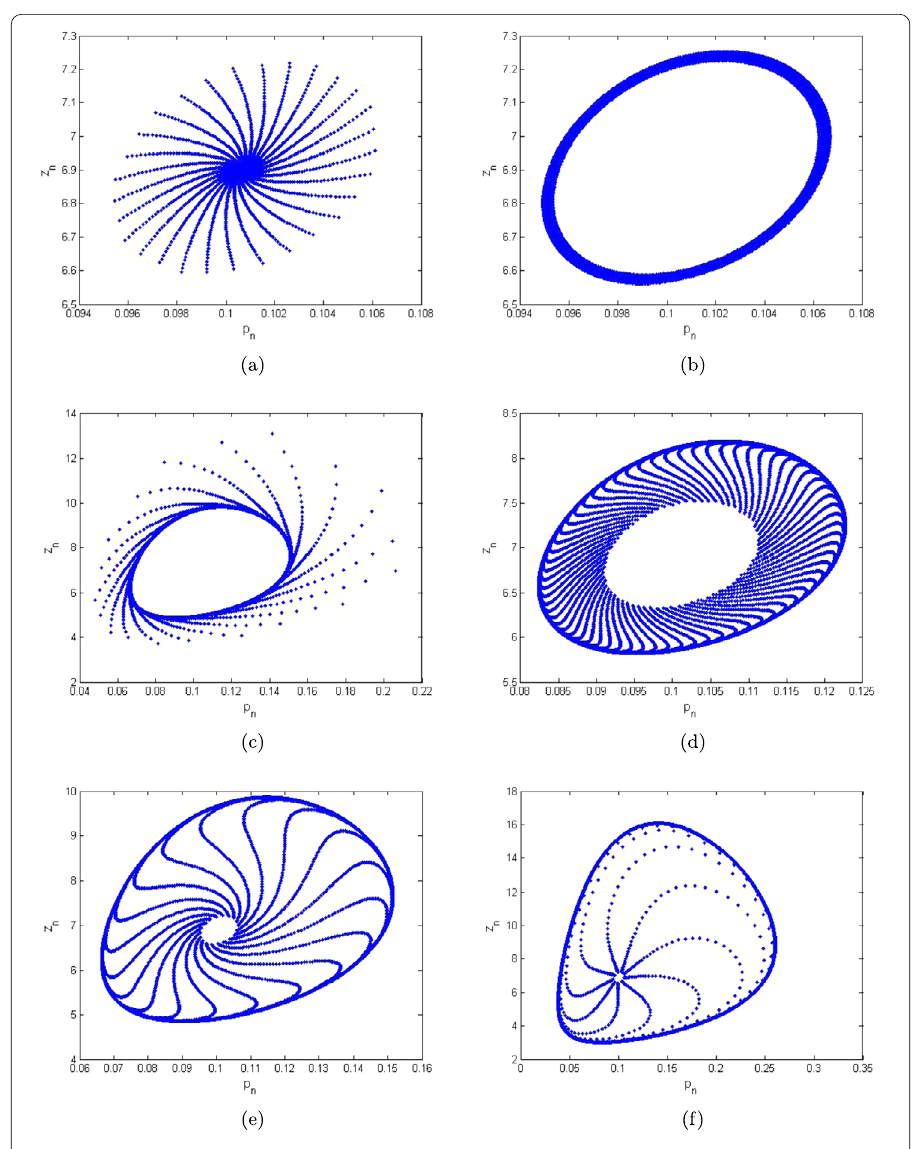
Figure 3 Phase portraits of system (1.5) for a = 2.0099, q 1 = 0.0189, q 2 = 1.2994, r = 10.5923, E = 0.9959, k = 1.3997, β = 98.499, α = 2.9999, δ = 0.0384, ρ = 10.5842, m 1 = 0.6222, m 2 = 0.4422, and h ∈